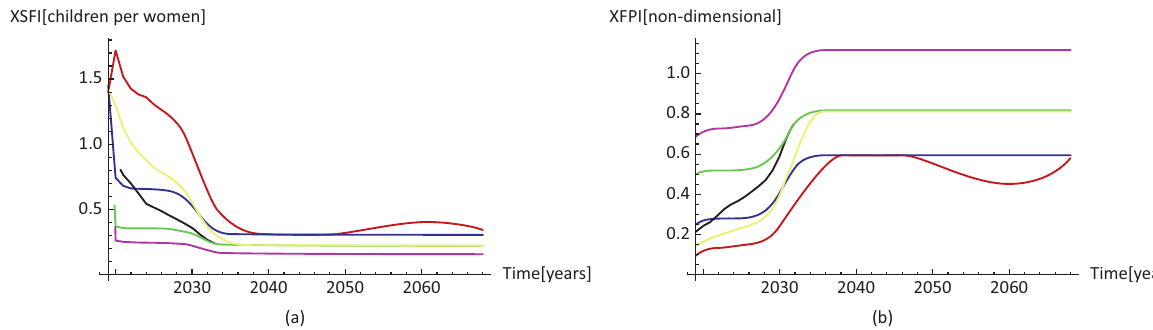
Figure 5. Future simulation (2019–2060) of fertility in Spain depending on different strategies. Notes: The red line rep‐ resents Strategy 1; the black line represents Strategy 2; the green line represents Strategy 3; the blue line represents Strategy 4; the yellow line represents Strategy 5; the purple line represents Strategy